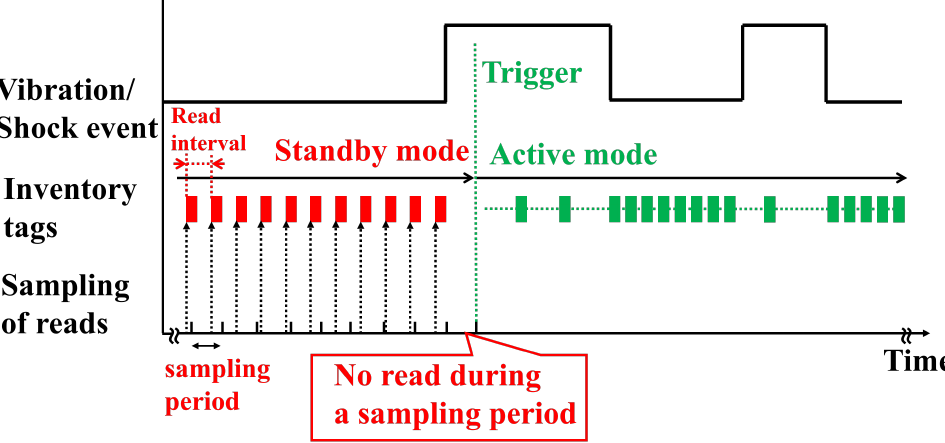
Figure 3. Monitoring principle for long-term